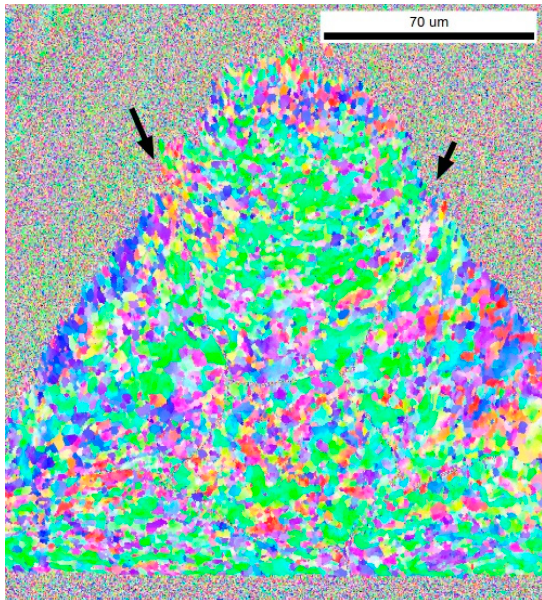
Figure 5. Inverse pole figure (IPF) map taken from the cross-section of the wire cut perpendicular to the wire direction.